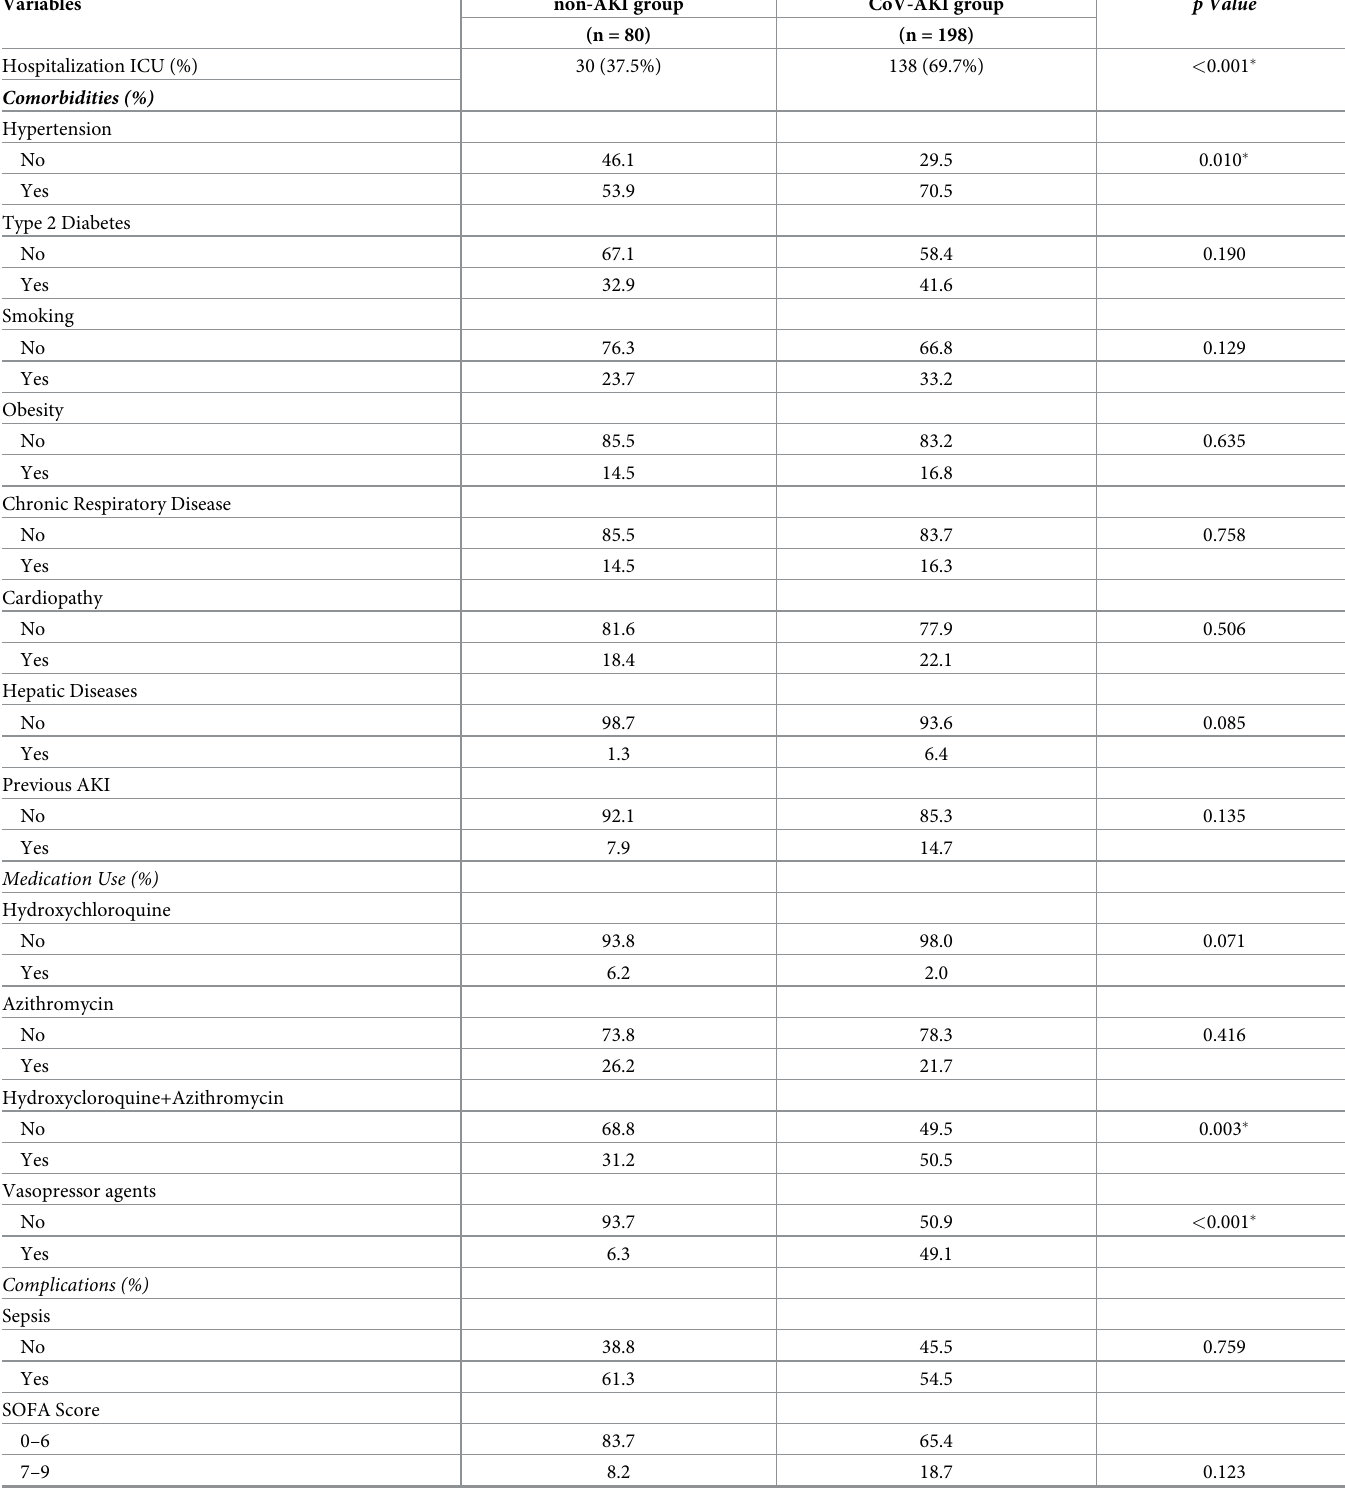
Table 2. Overall description of comorbidities, medication usage and general